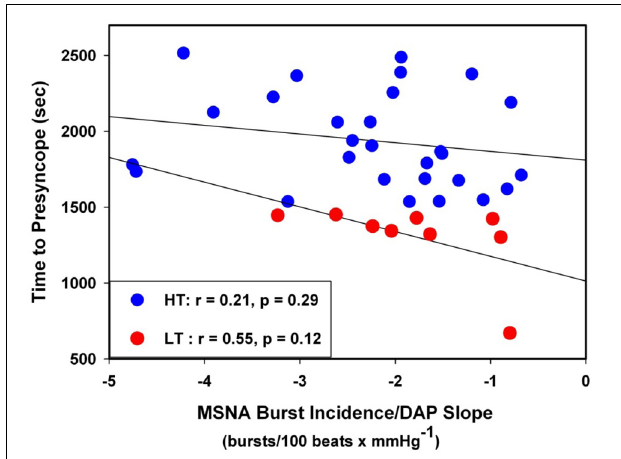
FIGURE 5 | Linear regressions between MSNA burst incidence/DAP slope and time to presyncope in low tolerant (LT) and high tolerant (HT)